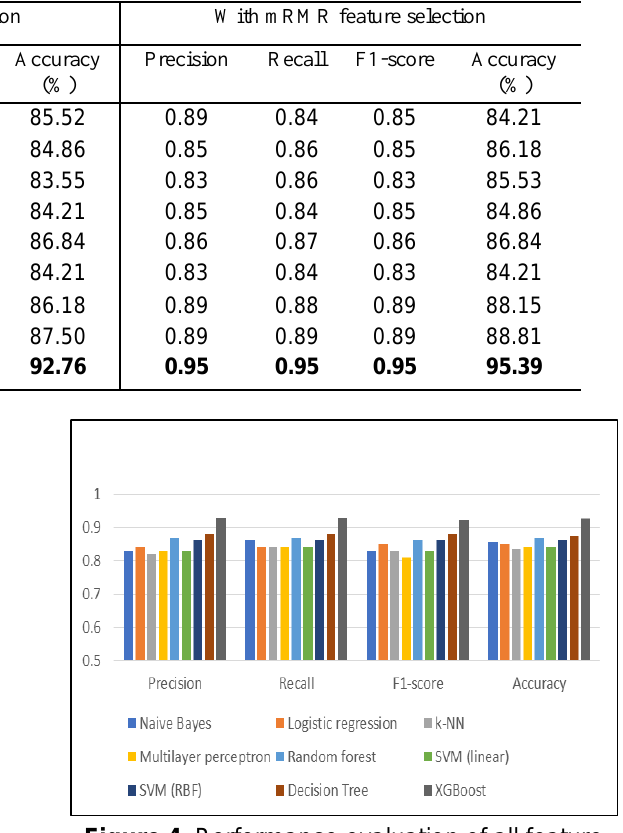
Figure 4. Performance evaluation of all feature subsets using RFE .